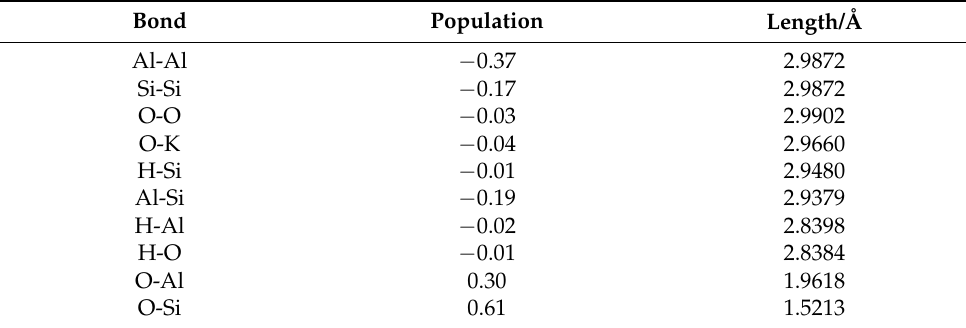
Table 3. The Mulliken bond population analysis of muscovite atoms.